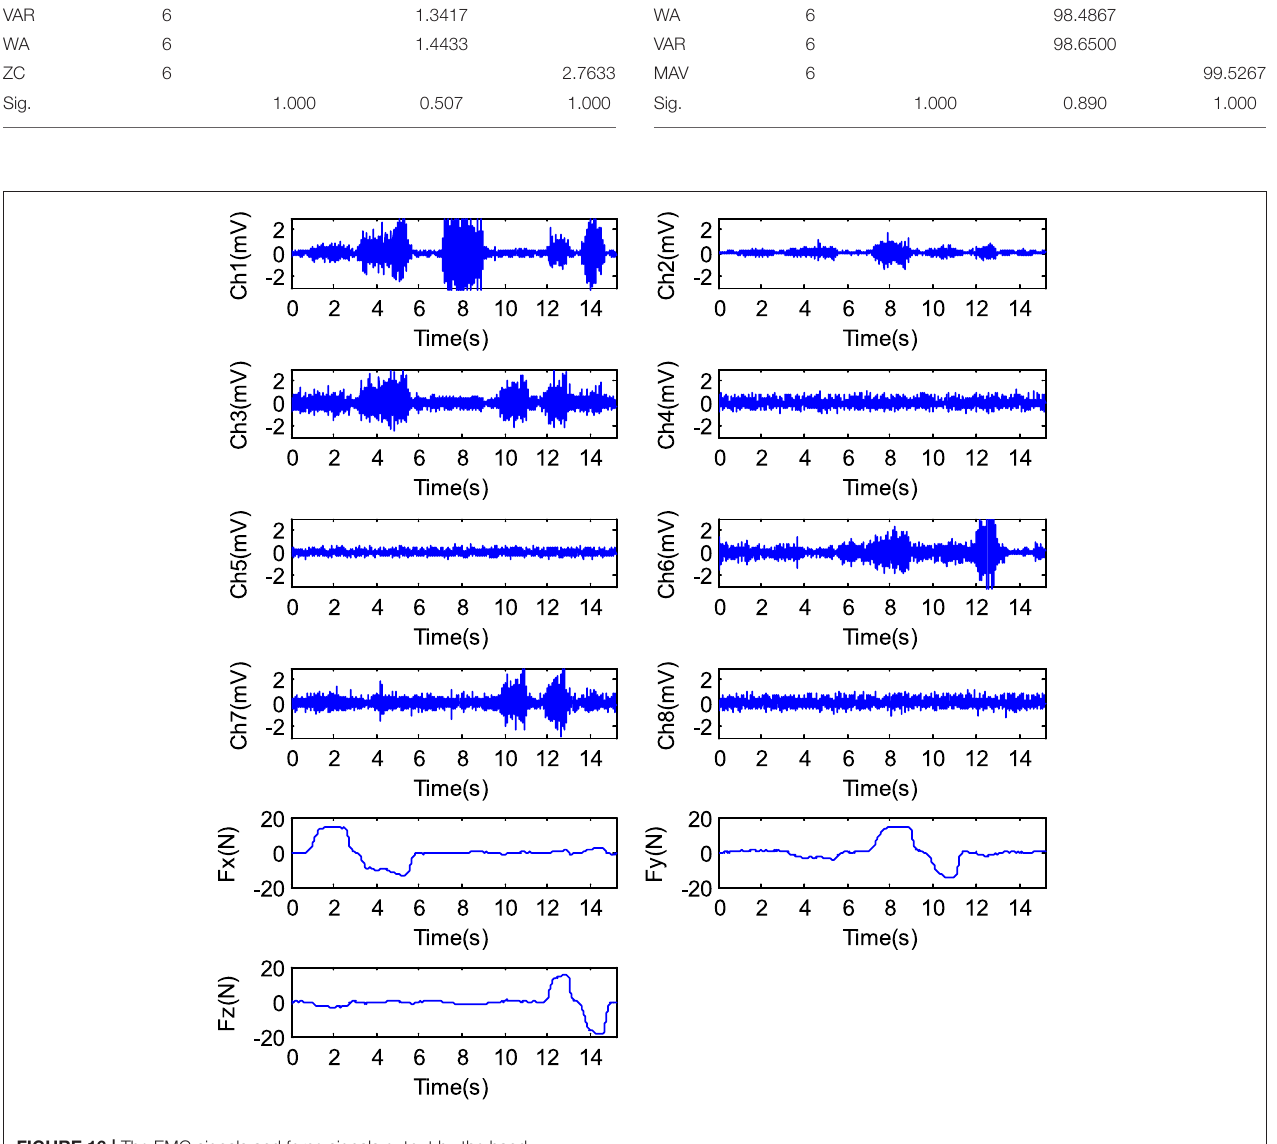
Frontiers in Neuroscience |